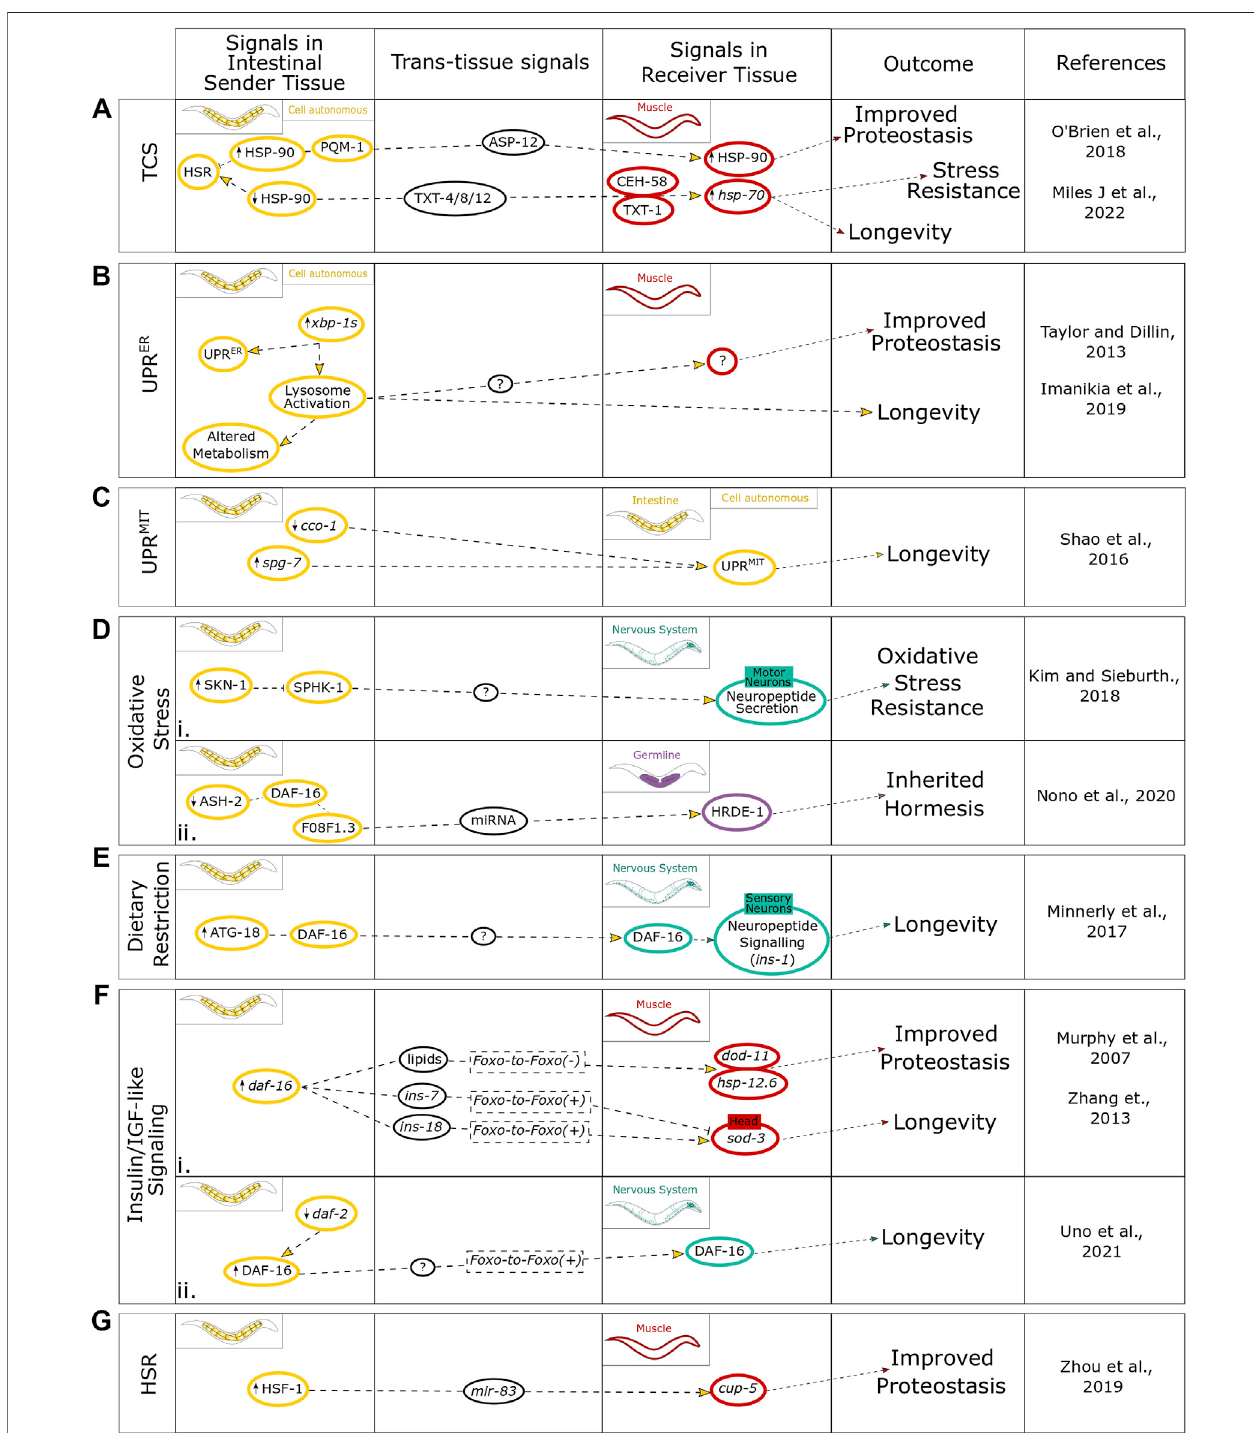
FIGURE 2 | Summary of intestinal regulation of cell nonautonomous stress signals in mediating organism physiology. The fi ndings for intestine-induced stresses within the context of (A) TCS cell autonomously and communicated to the muscle, (B) the UPR ER cell autonomously and communicated to the muscle, (C) the UPR MIT containedtoacellautonomousresponse, (D) oxidative stresscommunicatedtoboth (i)thenervoussystemand (ii)thegermline, (E) dietary restrictioncommunicatedto the nervous system, (F) IlS communicated to both (i) the muscle and (ii) the nervous system, and (G) the age-associated changes in the competency of the HSR. This fi gurehighlightsthesignalswithintheintestinalsendertissue,signalsinvolvedinthetrans-tissuecommunication,andsignalswithinthedifferentreceivertissuesand how they link to different physiological outcomes.